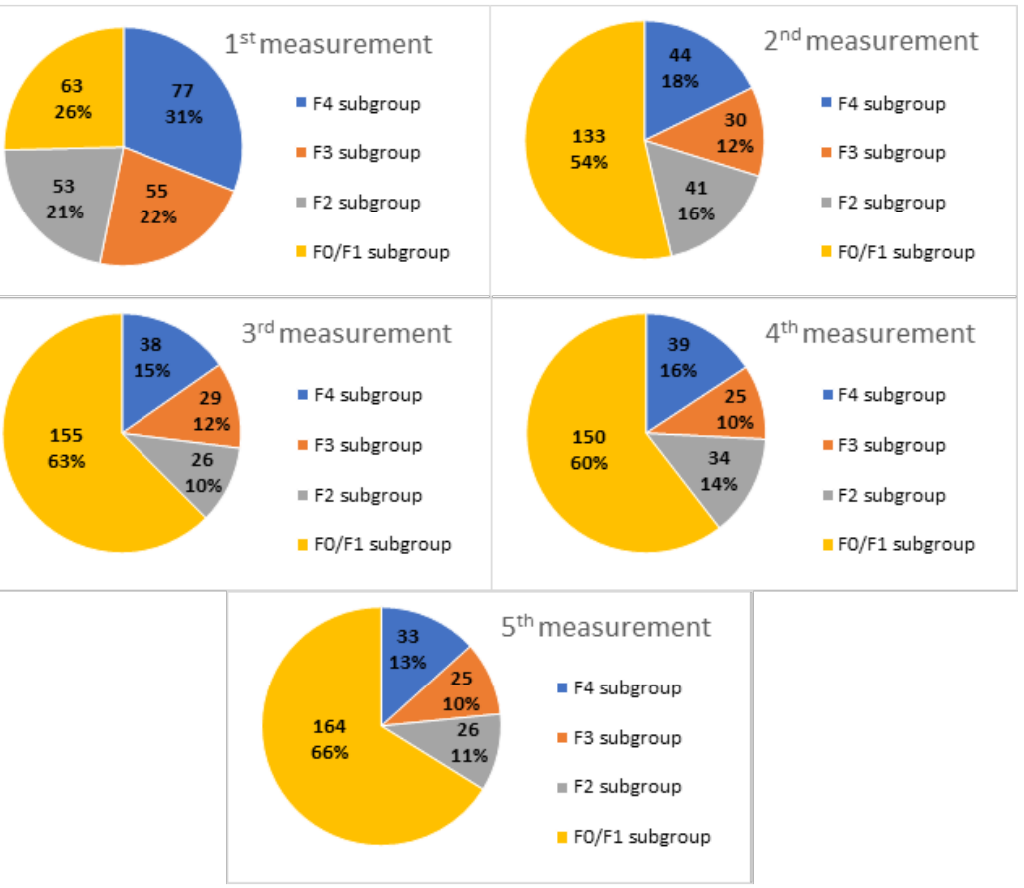
Table 4. Quantitative description of the distribution of patients in subgroups according to changes in the fibrotic stage throughout the follow-up period.